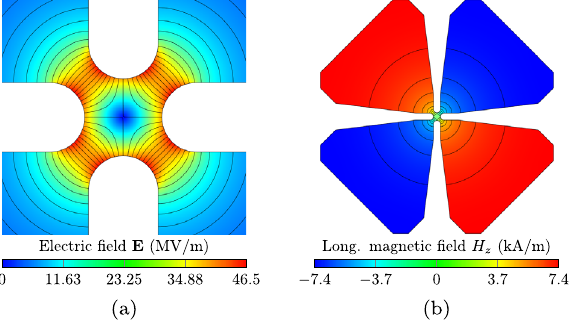
FIG. 26. Electric field lines at the equidistant vane tips of a cell without modulation for the quadrupole mode (a), and magnetic field (b), where the lines connect points of equal amplitude.